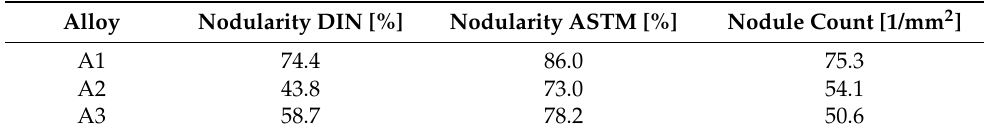
Table 2. Results of graphite analysis on alloys A1–A3.